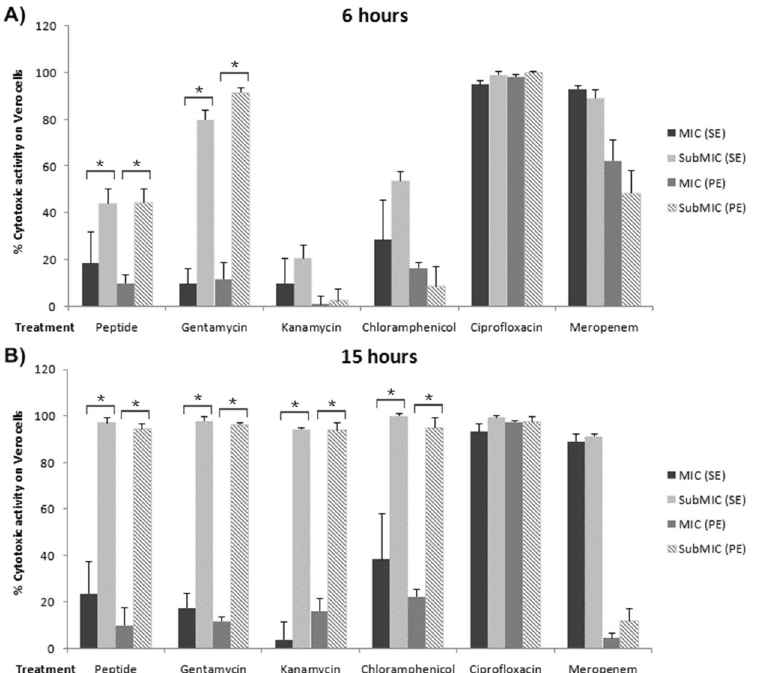
Figure 2. Vero cell cytotoxicity levels with secreted (SE) and seriplasmic (PE) lysates from STEC 86–24 following treatment with peptide or antibiotic after ( A ) 6 hr and ( B ) 15 hr. Antimicrobial doses included both MIC and subMIC doses: peptide (128 µ g/mL and 64 µ g/mL), gentamicin (4 µ g/mL and 2 µ g/mL), kanamycin (16 µ g/mL and 8 µ g/mL), chloramphenicol (8 µ g/mL and 4 µ g/mL), ciprofloxacin (0.063 µ g/mL and 0.031 µ g/ mL) and meropenem (0.063 µ g/mL and 0.031 µ g/mL). All assays were carried out in triplicate and on at least two different occasions. Data bars represent means ± standard deviation. * Significantly different from subMIC treatment; P < 0.05; Unpaired student’s test with Welch’s